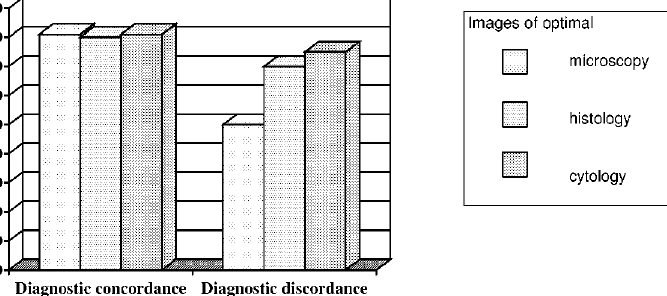
Fig. 5. Relation of excellent image quality of macroscopy, histology and cytology in correct diagnoses versus false or referred diagnoses (in percent of analyzed cases).